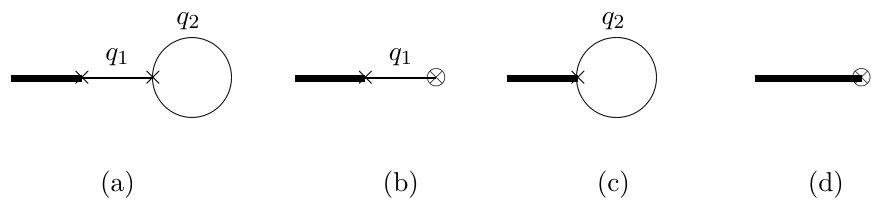
Figure 7 . This figure shows the Feynman diagrams contributing to the annulus amplitude with one external closed string. The interaction vertex with a × represents part of a disk amplitude, while the interaction vertex with ⊗ represents annulus amplitude. As in figure 4, the q i ’s represent the sewing parameters of the corresponding